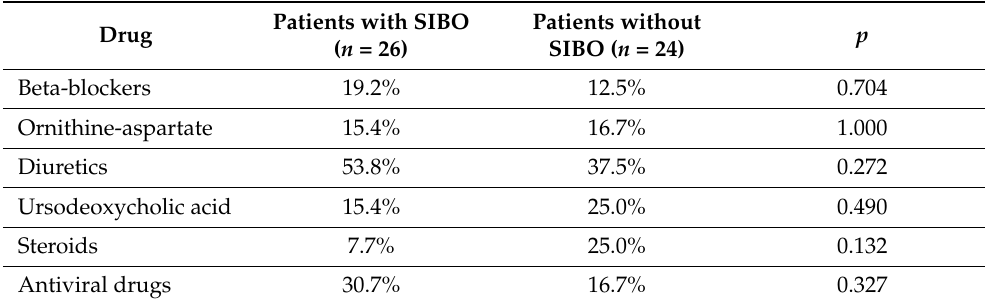
Table 2. Drugs used by patients with small intestinal bacterial overgrowth (SIBO) and without it.